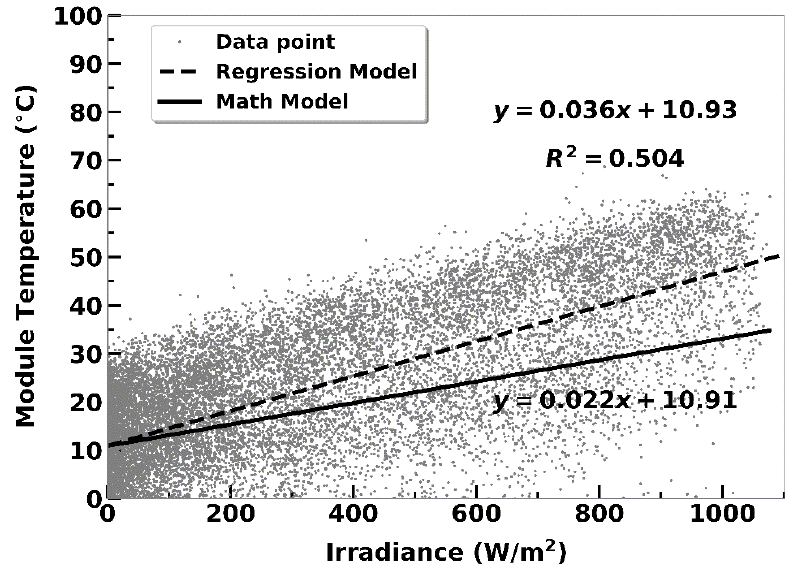
Figure 9. Two dimensions processed data of NIST photovoltaic data set—irradiance vs. module temperature.